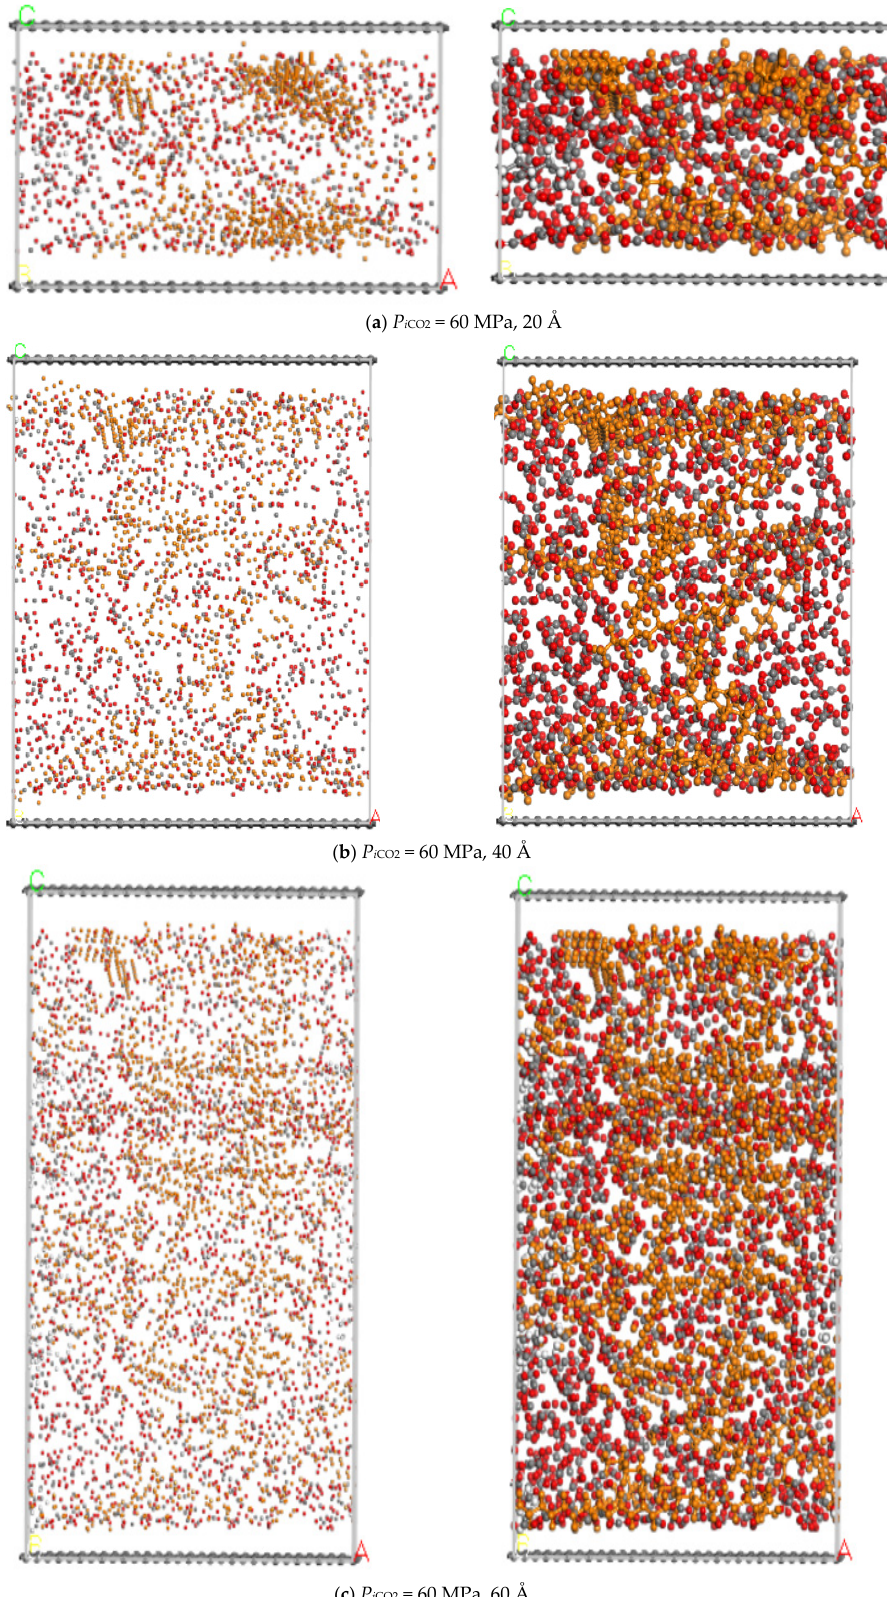
Figure 4. The schematic of instantaneous adsorption of molecules with CO 2 injection under 60 MPa in pores of different sizes. (A, B and C respectively represent different coordinate directions).